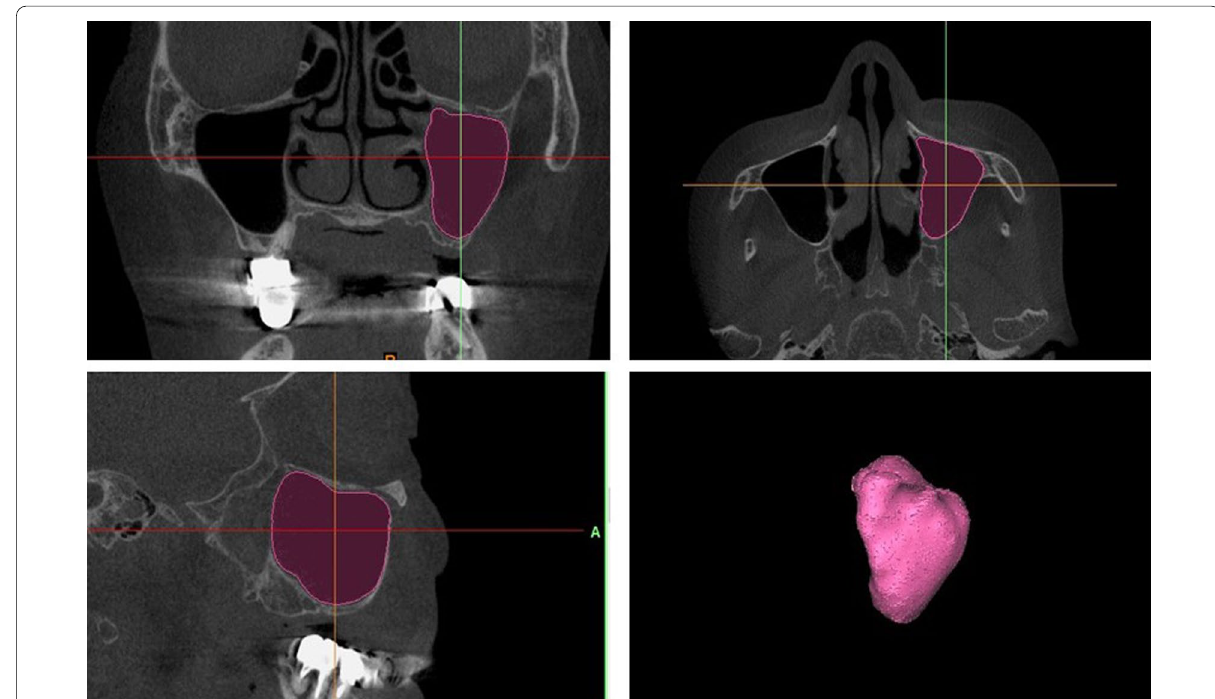
Fig. 1 Method for measuring MSV. Upper-left: Visualization of the maxillary sinus in the coronal plane. Lower-left: Visualization of the maxillary sinus in the axial plane. Upper-right: Visualization of the maxillary sinus in the sagittal plane. Lower-right: Visualization of the maxillary sinus in three dimensions. MSV maxillary sinus volume